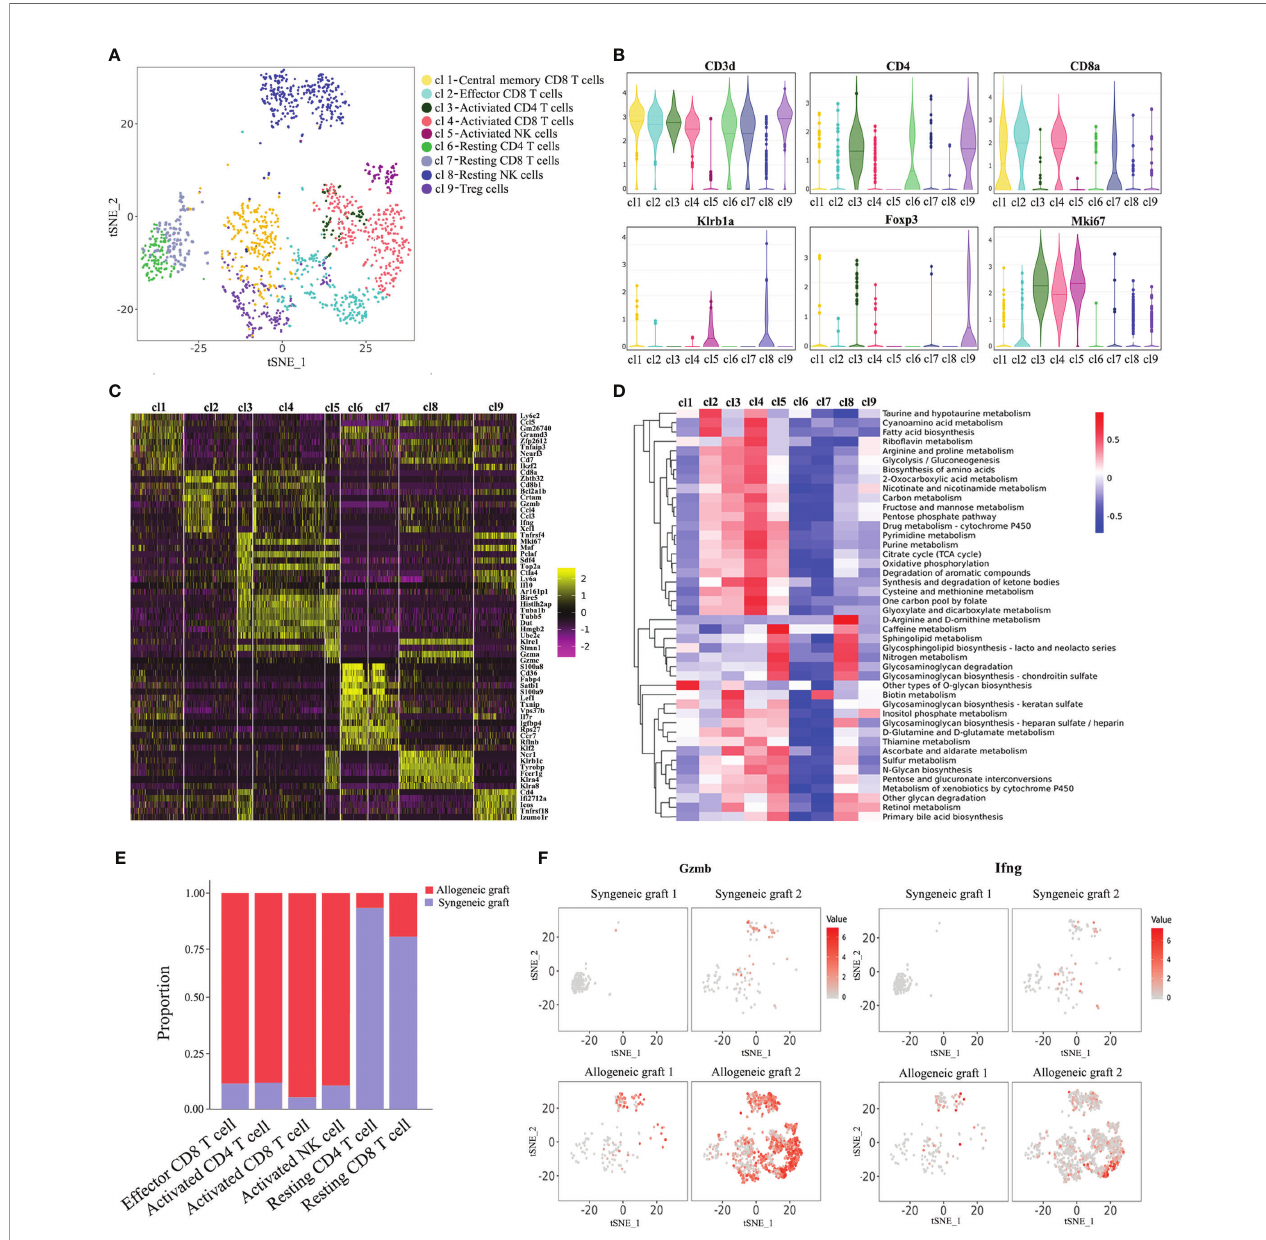
FIGURE 2 | Characterization of T cells and NK cells. (A) Reclustering of T/NK cells with the t-SNE plot identifying seven T cell populations and two NK cell populations. (B) Violin plots displaying the expression of representative cell markers (CD3d for T cells, CD4 for CD4 + T cells, CD8a for CD8 + T cells, Klrb1a for NK cells, Foxp3 for Treg cells, Mki67 for proliferating cells). The y axis shows normalized read counts. (C) Heatmap of all T/NK cells clustered by recursive hierarchical clustering and Louvain – Jaccard clustering (Seurat) showing gene expression signatures in each cell population. (D) Quantitative Set Analysis for Gene Expression (QuSAGE) analysis examining active cellular metabolic pathways in each T/NK cell population. (E) Proportion of cells in each T/NK cell cluster from allogeneic or syngeneic graft. (F) Expression of Gzmb and Ifng in the allogeneic and syngeneic heart grafts in the t-SNE plots as shown in (A)